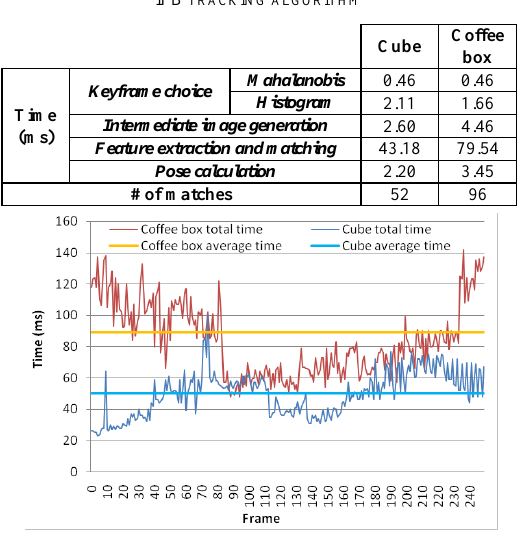
Figure 19. IPB total computation times for each of the first 250 frames of the sequences.